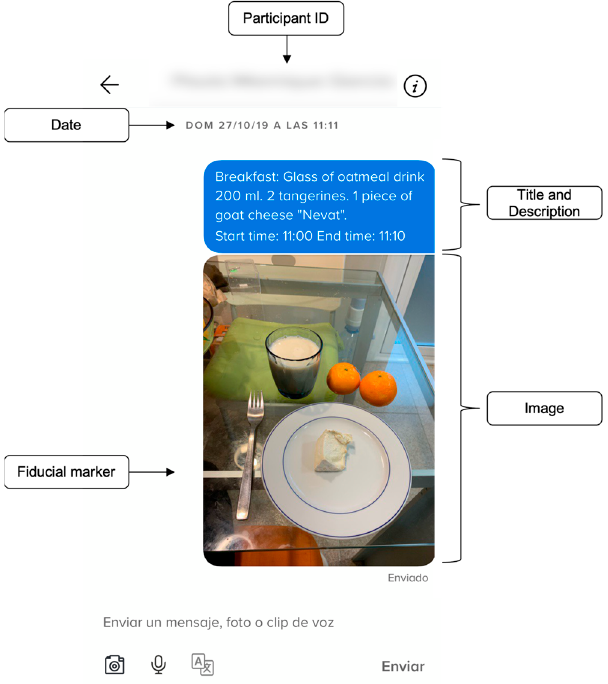
Figure 1. Example of an eating occasion recorded in the Remind app, including supporting text description, fiducial marker, date, and title of record.